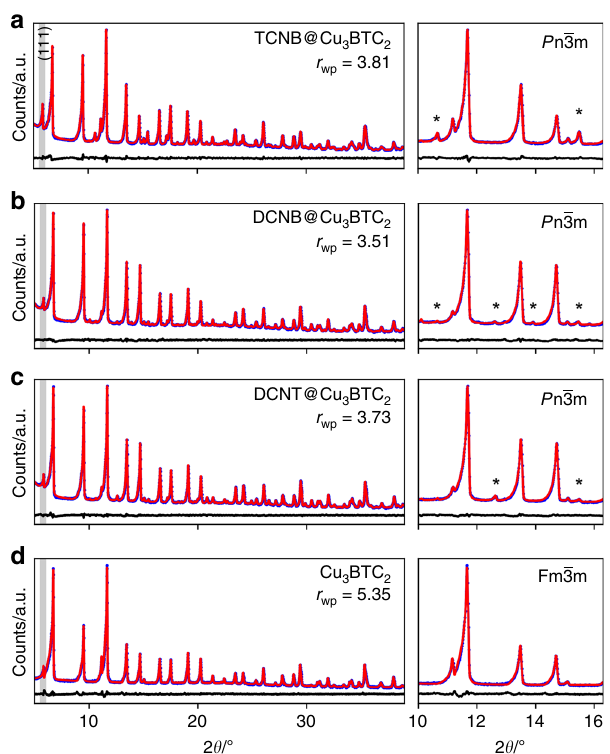
Fig. 5 PXRD data and Pawley pro fi le fi ts for CL@Cu 3 BTC 2 . Pristine Cu 3 BTC 2 d crystallizes in the face-centered cubic space group F m-3m. Upon retro fi tting with CL = TCNB a , DCNB b , or DCNT c , new re fl ections occur (zoom in) which can be accounted for by using the primitive space-group P n-3m. Experimental data, Pawley pro fi le fi ts and difference curves are shown in blue, red, and black, respectively. The r wp fi tting parameters are provided in the top right corner, respectively. The (111) re fl ection at 5.8° is indicated in gray